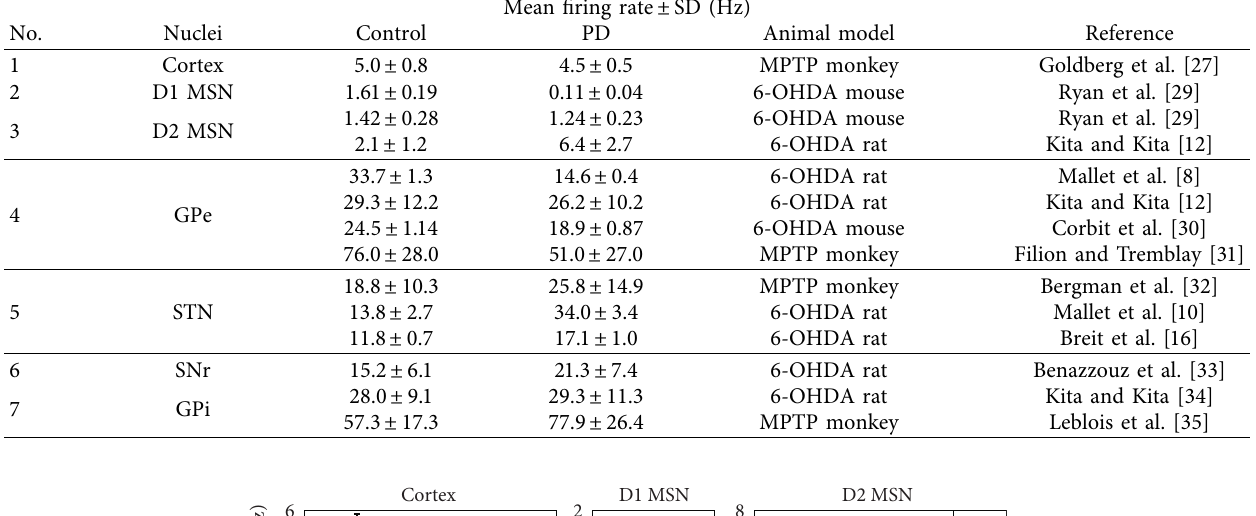
Table 1: Changes of the neuronal mean firing rates within the cortico-BG circuits observed in 6-OHDA rats/mice or MPTP monkeys in control (normal) and parkinsonian